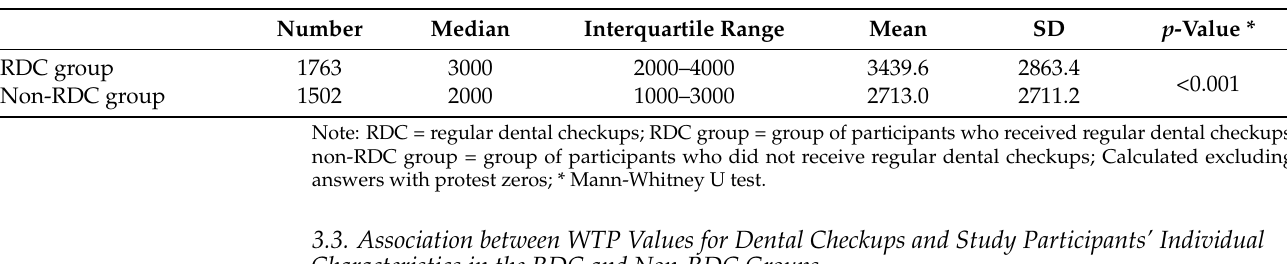
Table 2. Comparison of WTP values for dental checkups in the RDC group and the non-RDC group.